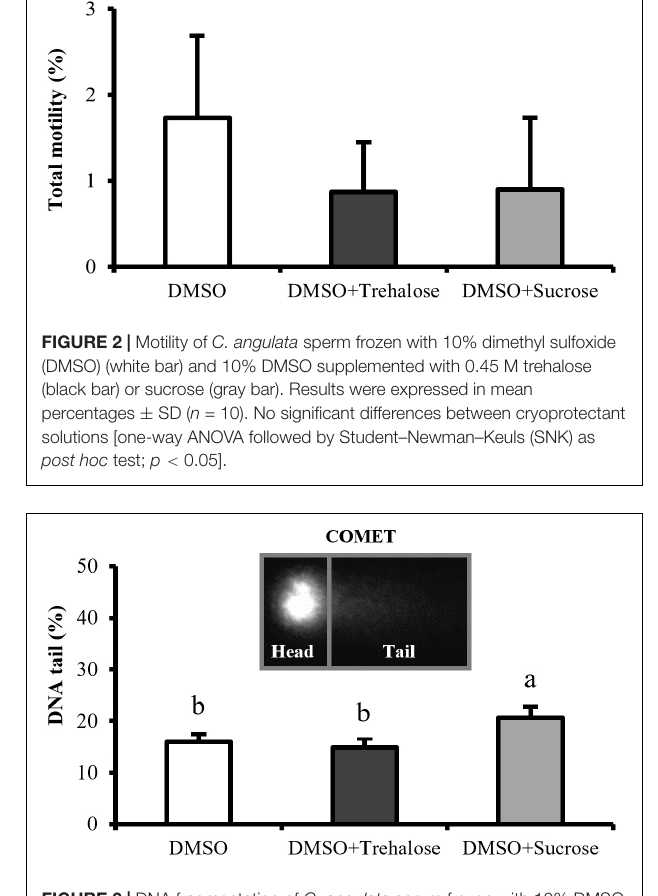
FIGURE 3 | DNA fragmentation of C. angulata sperm frozen with 10% DMSO (white bar) and 10% DMSO supplemented with 0.45 M trehalose (black bar) or sucrose (gray bar). Results were expressed in mean percentages of DNA in the tail ± SD ( n = 5). Different letters show differences between cryoprotectant solutions (one-way ANOVA followed by SNK as post hoc test; p <